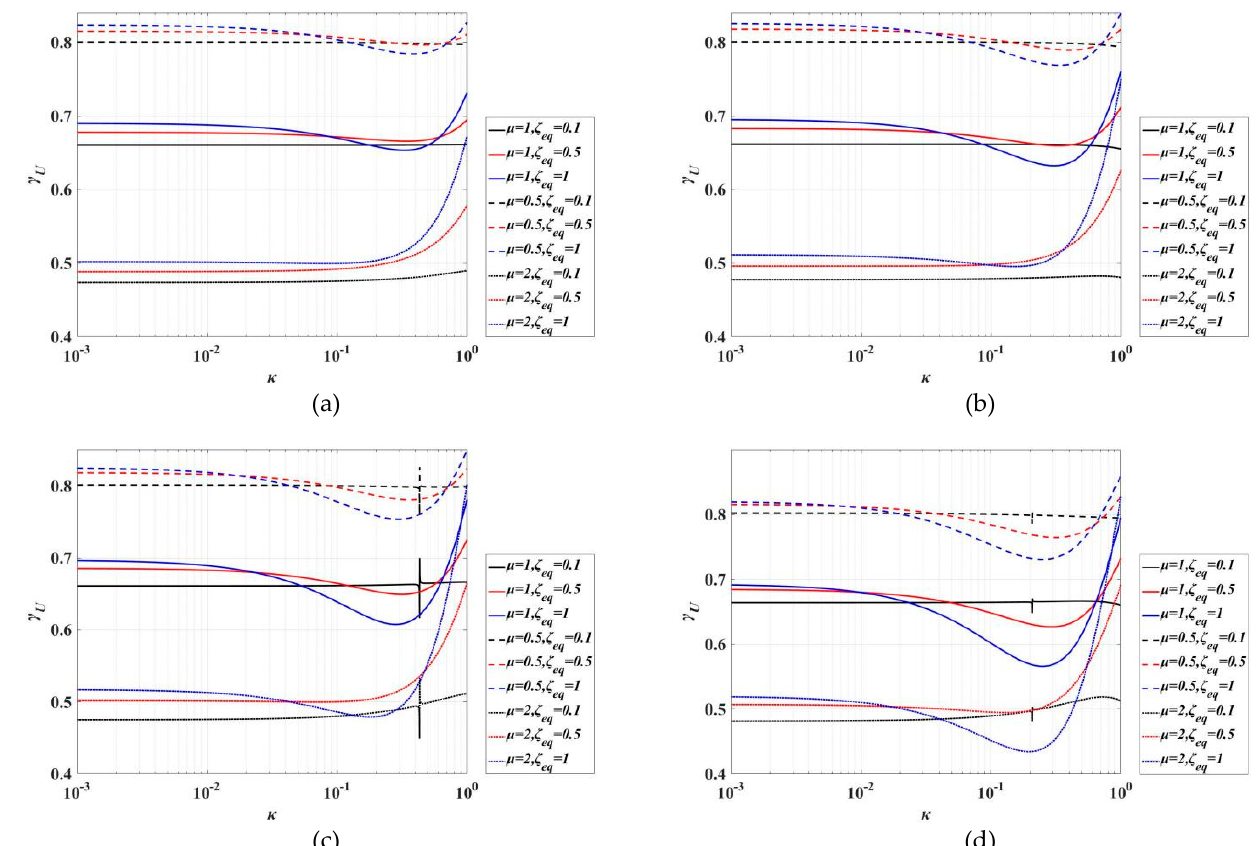
Figure 5. Curves of γ U : ( a ) HB – 1 ; ( b ) HB – 2 ; ( c ) LB–1 ; ( d ) LB–2 .